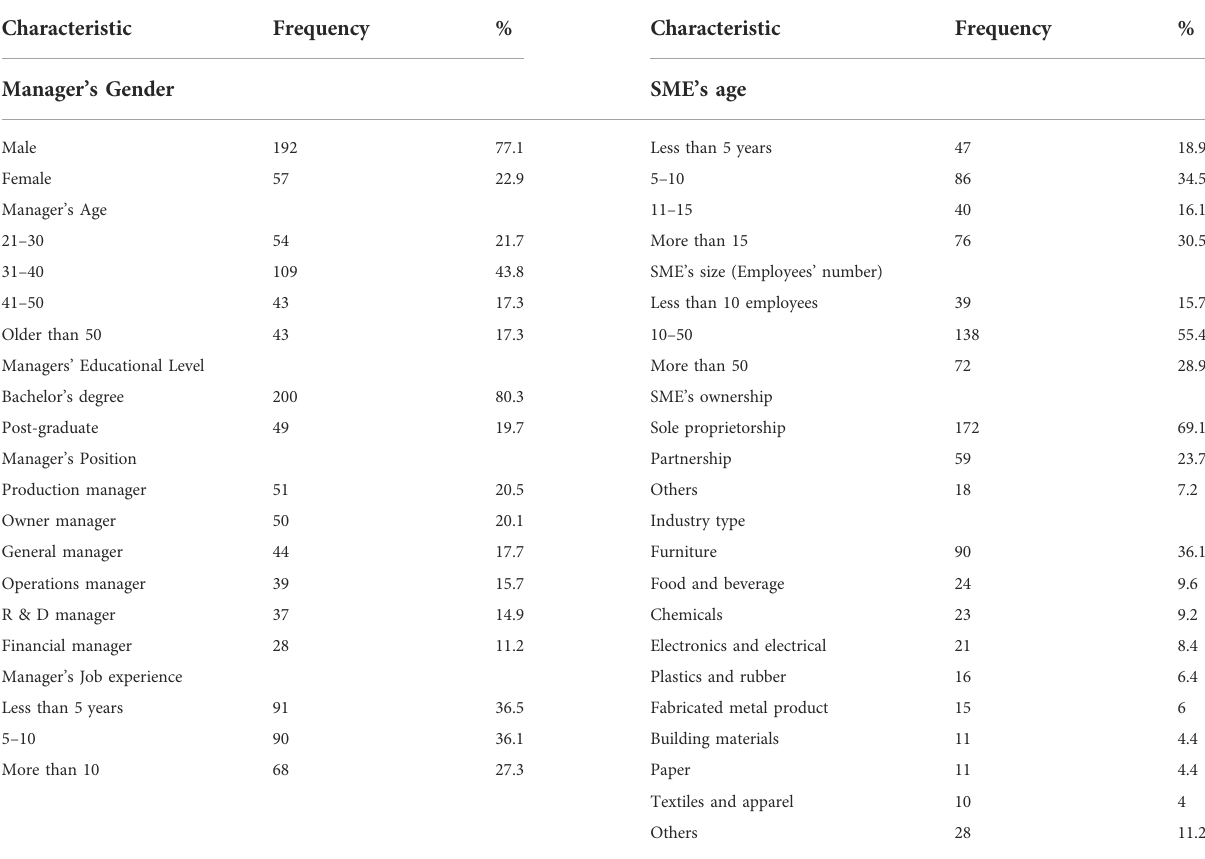
TABLE 1 The demographic characteristics of managers and SMEs ( n =